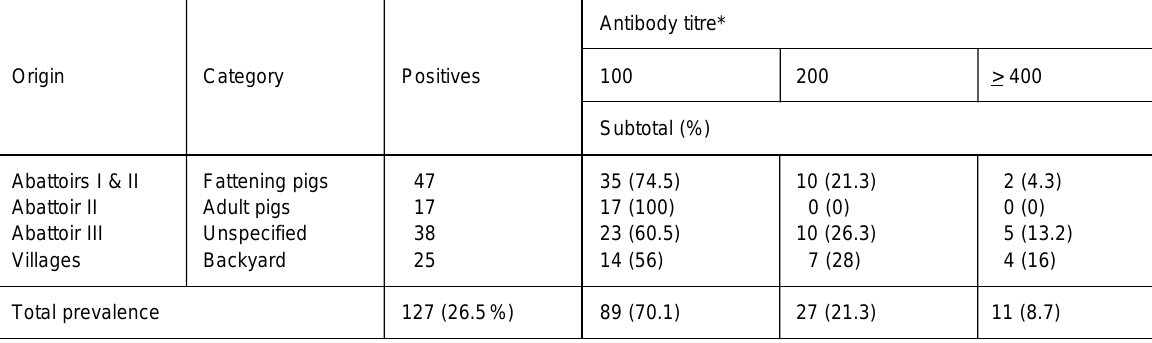
TABLE 4 Distribution of the Toxoplasma gondii seropositive pigs according to antibody